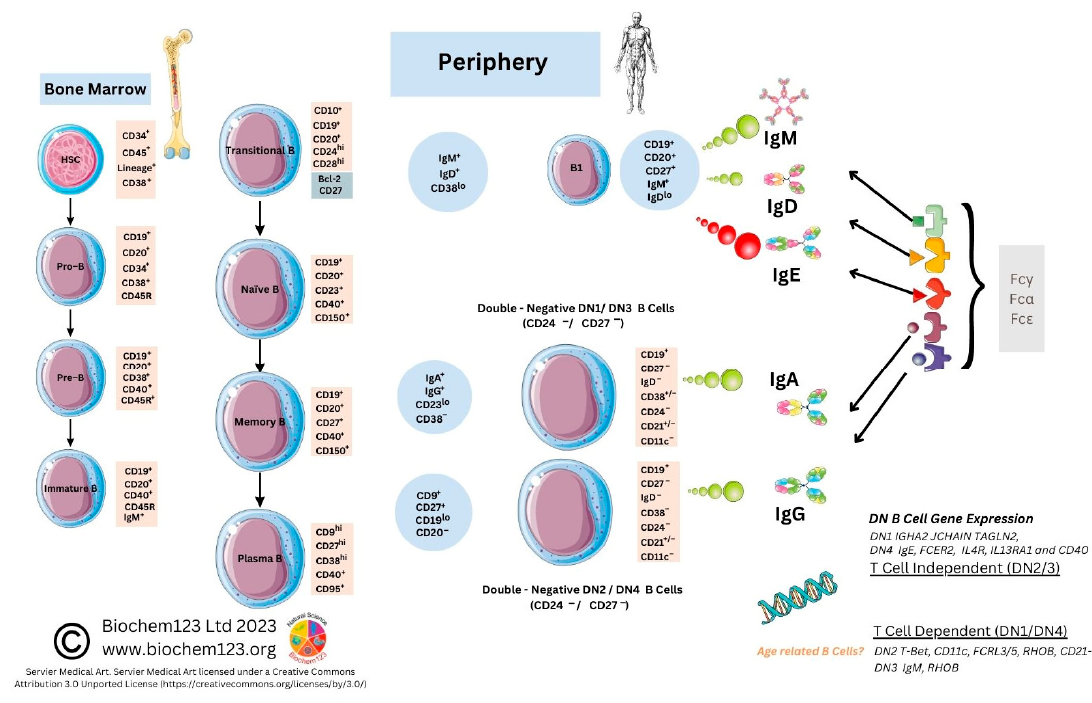
Figure 3. B cell phenotypes during maturation. Antibody isotypes concentrations in sera and complement activation ability